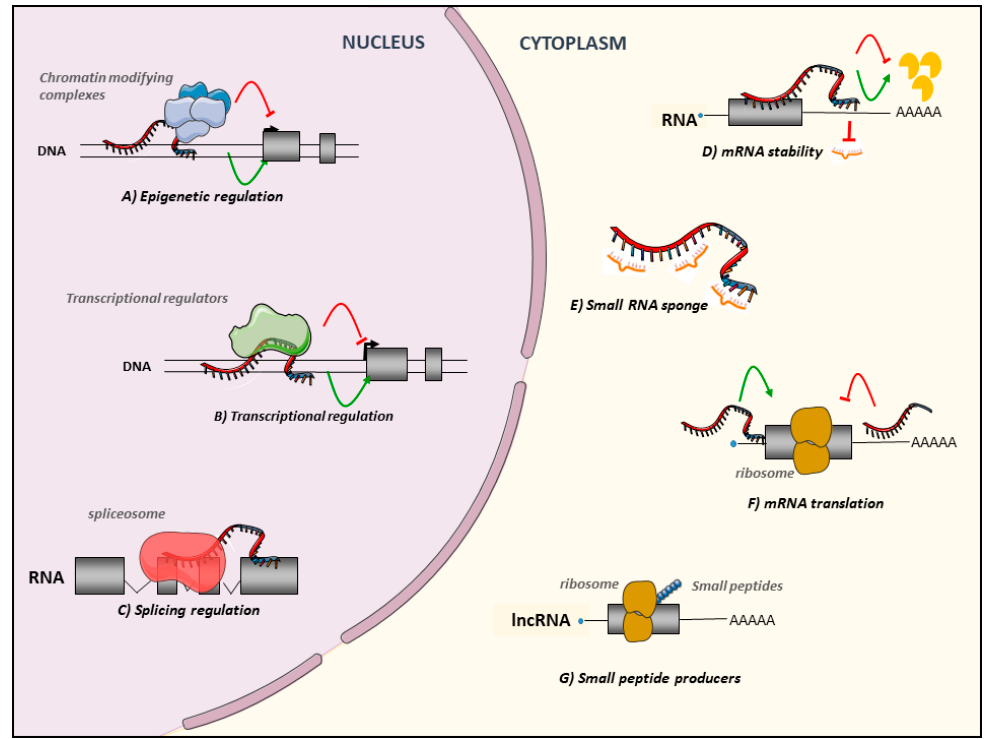
Figure 1. Long Noncoding RNAs: a truly large and multifaced family. Nuclear lncRNAs are implicated in ( A ) Epigenetic regulations, leading to the recruitment of activator/repressor chromatin modifying complexes on their target promoters, ( B ) Transcriptional regulations, guiding or preventing the recruitment of transcription factors on the promoters of their targets or on other active chromatin sites, ( C ) Splicing regulations regulating recruitment of spliceosome partners. Cytoplasmic lncRNAs also affect post ‐ transcriptional steps regulating ( D ) mRNA stability modulating degradation, positively or negatively or acting as ( E ) small regulatory RNA sponges. Finally, they regulate ( F ) mRNA translation. LncRNAs can also be ( G ) small peptide producers.